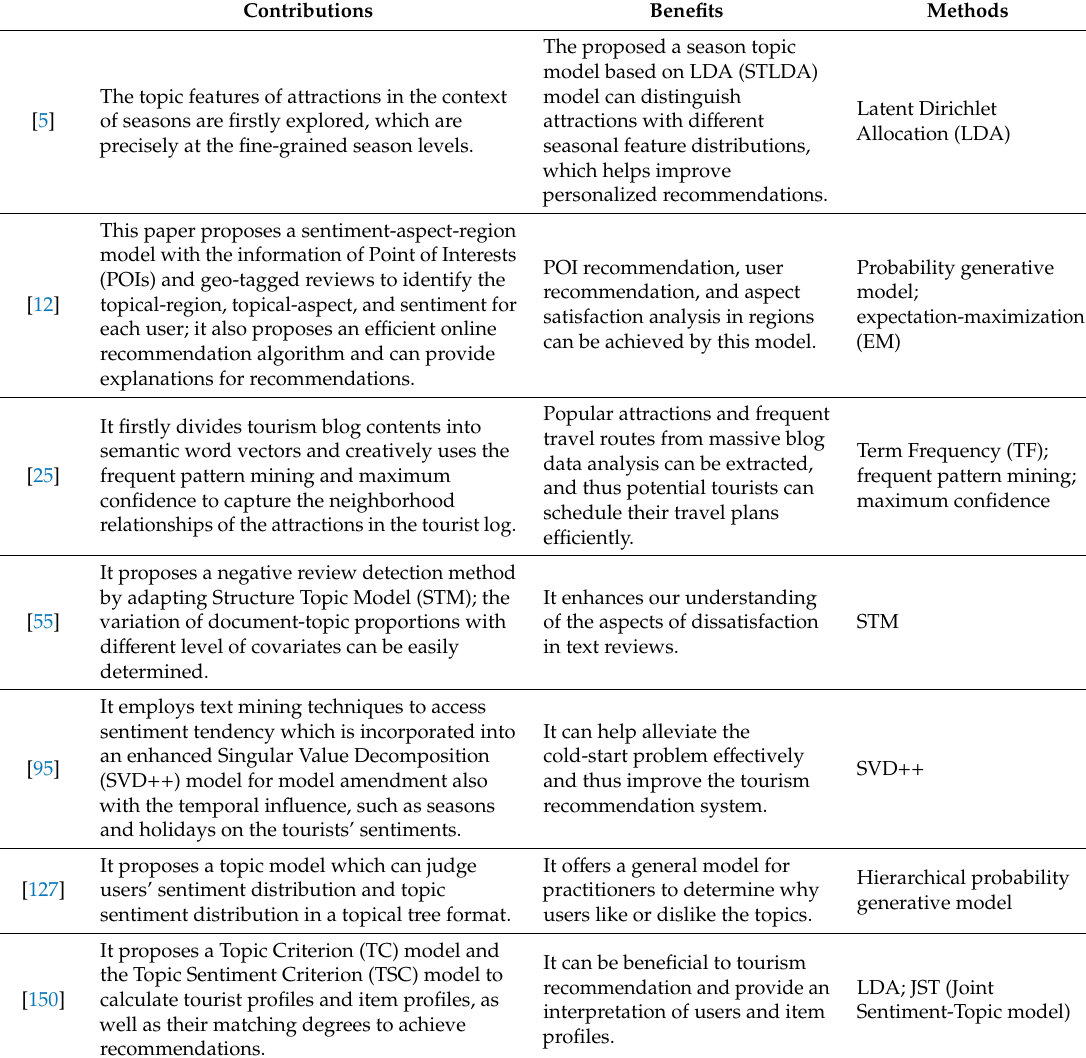
Table 6. Informative articles about text corpus-based tourism big data mining between 2015 and